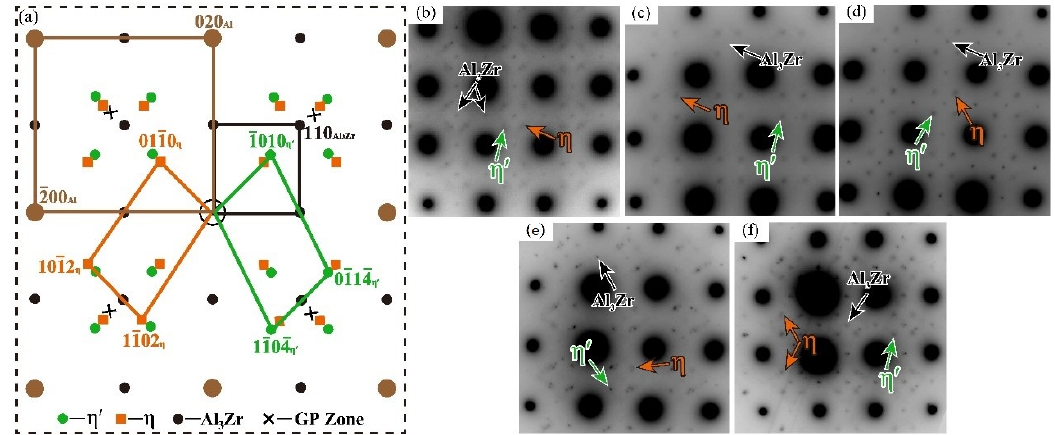
Figure 5. ( a ) Schematic representation of the (001) Al pattern and SAED patterns along (001) Al zone axis of the 7085 alloy after various heat treatments: ( b ) sample I (25 °C), ( c ) sample II (100 °C), ( d ) sample III (125 °C), ( e ) sample IV (150 °C), and ( f ) sample V (175 °C).